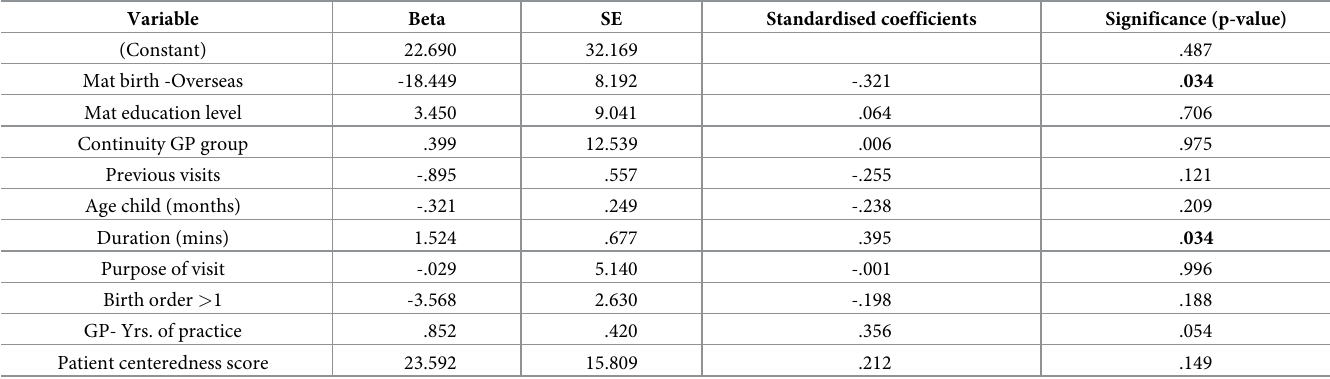
Table 4. Multiple regression analysis.